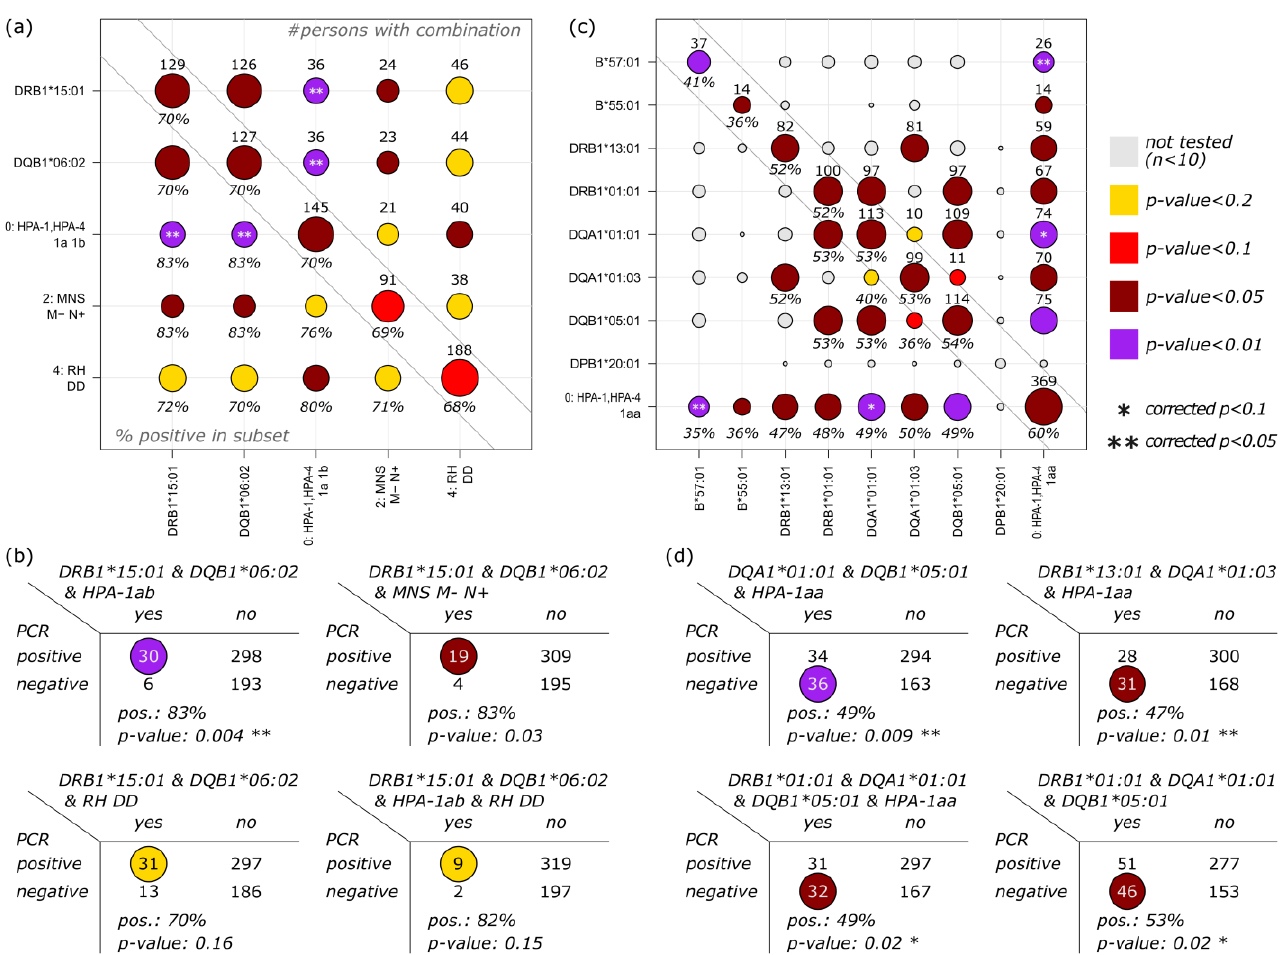
Figure 5. Combined analysis of HLA alleles and blood groups: ( a ) pairwise combinations of alleles and/or blood groups identified to enrich PCR positive persons are shown, together with the number of persons with the particular characteristics (upper triangle) and proportion of PCR positive persons within this subcohort (lower triangle). Colors indicate enrichment, as obtained from Fisher’s exact test. Enrichments with p -values < 0.1/0.05 after Bonferroni correction are highlighted with asterisks. Numbers and percentages along the diagonal reflect properties of single HLA alleles or blood group characteristics, as discussed above. ( b ) Combinations of three or four of the selected characteristics were evaluated for enrichment in the positive subcohort in terms of 2 × 2 contingency tables of each phenotype. p -values were calculated by Fisher’s exact test; see color legend. Combinations with fewer than 10 persons were rejected from this analysis. ( c ) Pairwise combinations of alleles and/or blood groups enriched in the negative subcohort. ( d ) Enrichment of combinations of three or four characteristics in the negative subcohort. Asteriks indicates the corrected p -values.